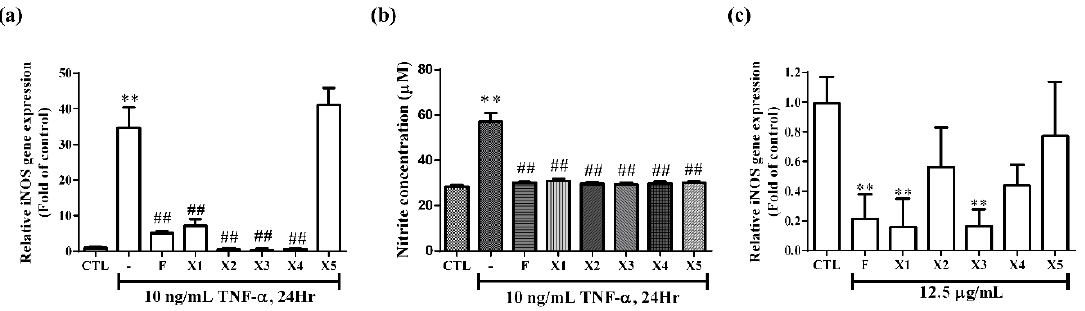
Figure 4. E ff ect of ferrocene-1 H -1,2,3-triazole hybrids on iNOS expression and NO production in RMCs. Cells were pretreated with the compounds at 12.5 µ g / mL for 2 h and subsequently stimulated with TNF- α (10 ng / mL) for 24h. The expression of iNOS and NO in RMCs were determined by ( a ) real-time PCR analysis and ( b ) nitric oxide assay, respectively. ( c ) Cells were incubated without or with F , X1 , X2 , X3 , X4 , or X5 at 12.5 µ g / mL for 24 h. The mRNA was extracted, reverse transcribed, and then analyzed the iNOS expression by real-time PCR. Data are expressed as fold of control (1% DMSO-treated group) and each column represents the mean ± SEM of at least three repeated and independent assays. Asterisks indicate a significant di ff erence compared with the control group, ** p < 0.01. Hashes indicate a significant di ff erence compared with the TNF- α -treated group, ## p < 0.01.